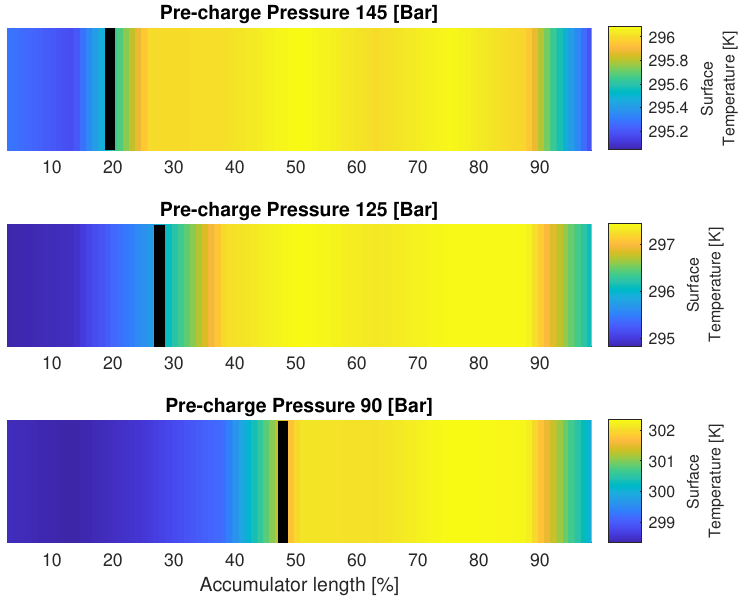
Figure 1. Mean surface temperatures for different pre-charge pressures. The fluid inlet is located on the left-hand side of the plot (also seen in Figure 2), which also denotes the initial piston position. The vertical black bar shows the final piston position. The surface temperature values are interpolated from eight evenly distributed sensors along the length of the